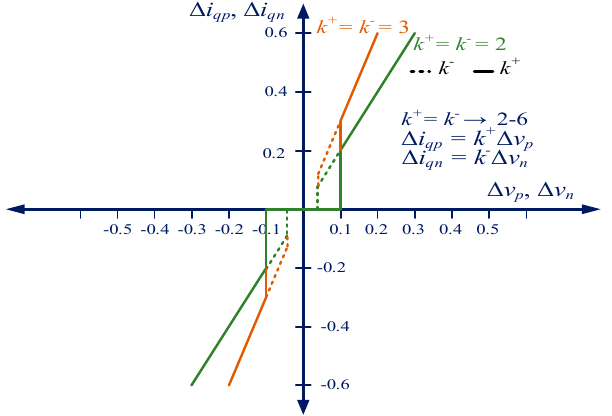
Figure 1. Current injection requirements of recent grid codes (VDEAR − N